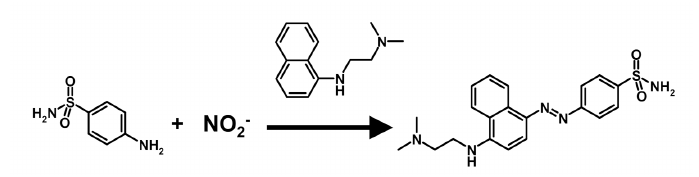
Figure 1. The reaction scheme of the Griess diazotization